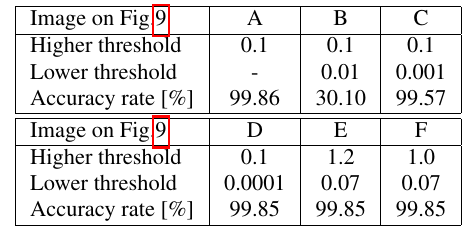
Table 3: The forest data, thresholds and accuracy rates for images on Fig. 9. A-C MLM, E-F Piecewise